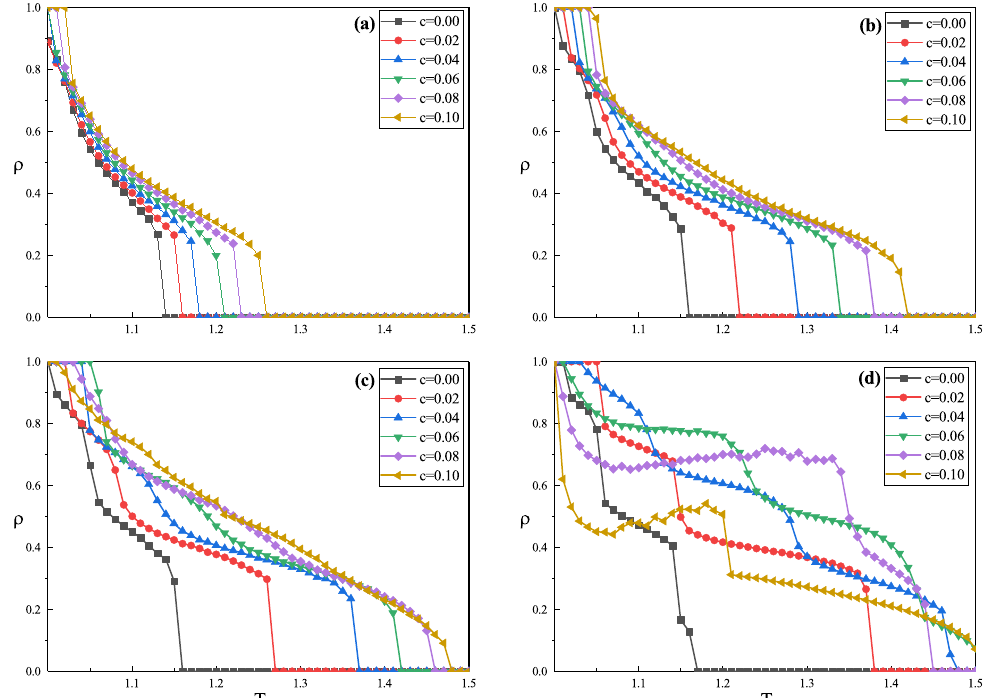
Figure 7. Fraction of cooperators as a function of the temptation to defect T for different information costs. Four panels ( a – d ) present the results for different n , where panel ( a ): n = 4; panel ( b ): n = 8; panel ( c ): n = 12; and panel ( d ): n = 24. Other model parameters are fixed as: L = 100, K = 0.1, q = 0.5 and c =